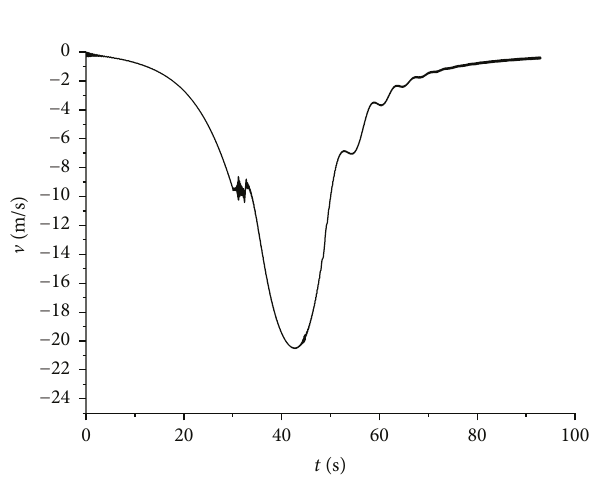
Figure 4: Velocity component v